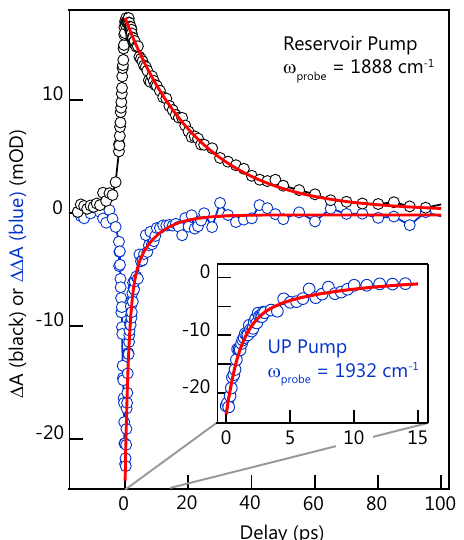
Fig. 5 Kinetics of the decay of the transient response of cavity-coupled SNP. The black circles are measurements of the transient response of the cavity-coupled system at 1888 cm − 1 , the peak of the reservoir excited-state absorption, as a function of time delay after exciting with a Reservoir-Pump fi lter. The red line is a fi t to an exponential decay with a 23 ps lifetime. The blue circles are the subtracted response measured at 1932 cm − 1 (i in Fig. 4c) as a function of time delay after exciting with a UP Pump fi lter. The corresponding red line is a fi t to a biexponential decay with time constants 1 and 8